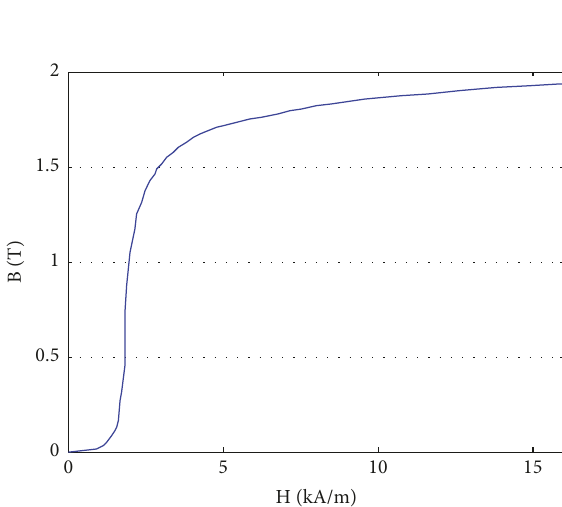
Figure 6: 𝐵 − 𝐻 curve of MRF2035.